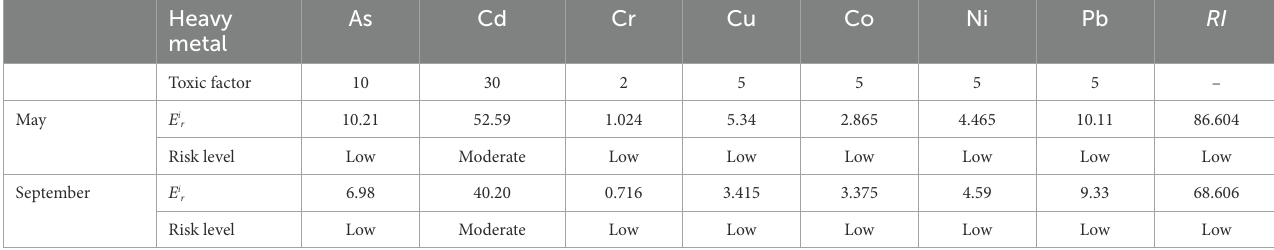
TABLE 4 The mean E ri and RI values of heavy metals in topsoil